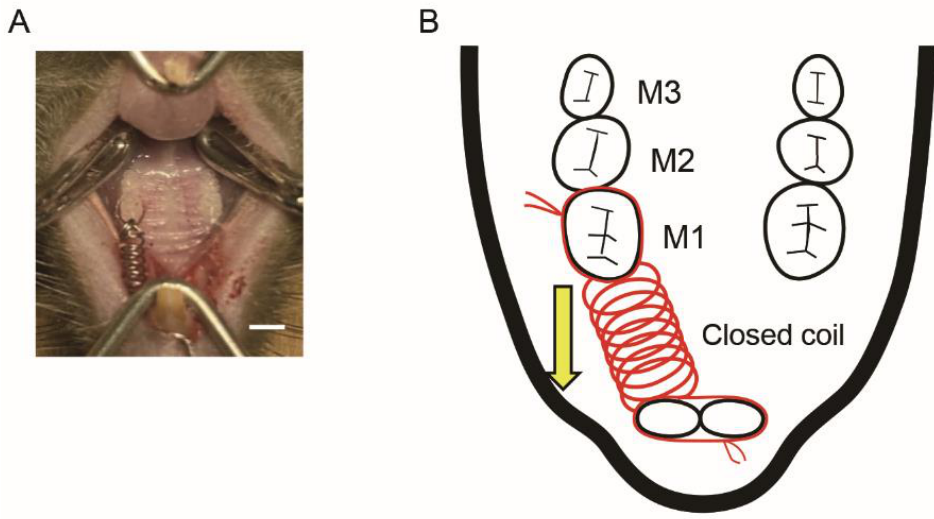
Figure 2. ( A ) A 10-gf Ni-Ti closed-coil spring was attached to the maxillary incisors and the maxil- lary left first molars (M1) of 8-week-old male WT and GIPRKO, and orthodontic tooth movement was administered for 14 days. Scale bar: 2.0 mm. ( B ) Schematic diagram of orthodontic tooth moving